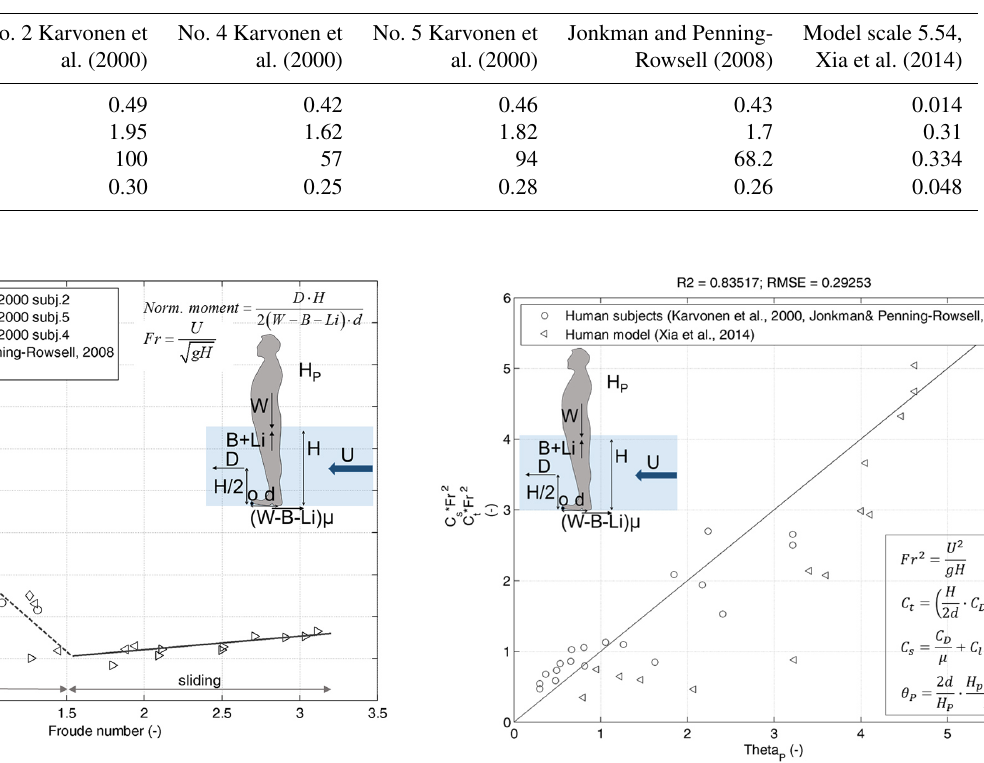
Figure 7. Comparison between experiments in terms of mobility parameter θ P and numerical results, with a distinction between the human subjects (circles) and human model (triangles). In the top of the Figure the determination coefficient R 2 and RMSE for the data on human-scale model Xia et al. (2014)